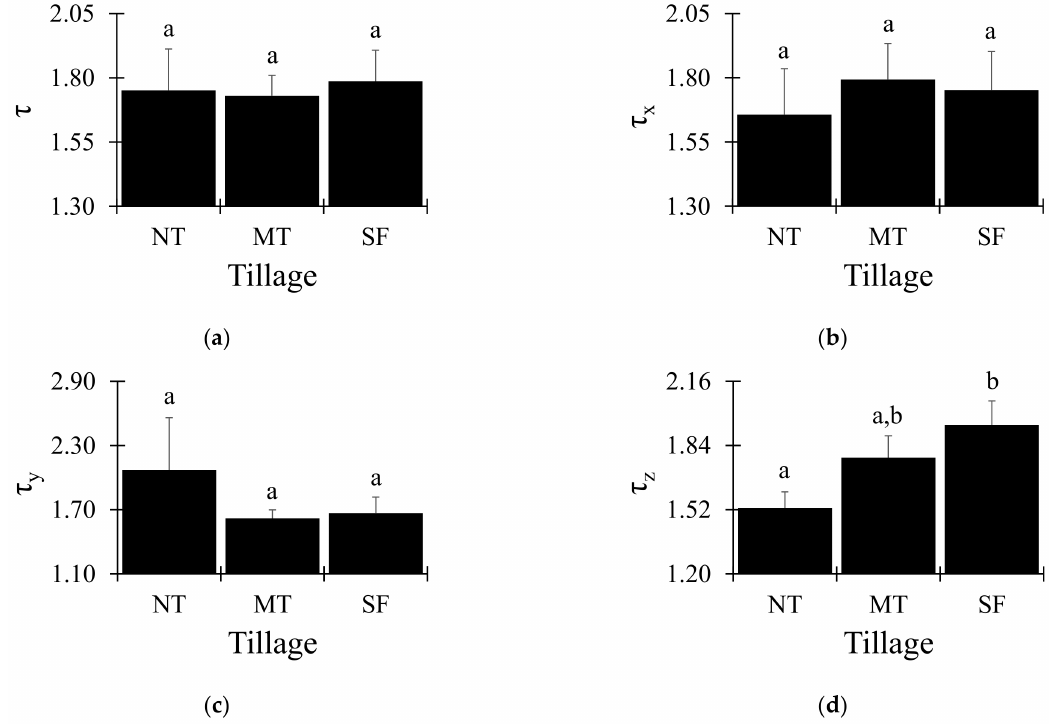
Figure 6. ( a ) Average pore tortuosity ( τ ), ( b ) pore tortuosity in the x direction ( τ x ) of the 3D image, ( c ) pore tortuosity in the y direction ( τ y ) of the 3D image, and ( d ) pore tortuosity in the z direction ( τ z ) of the 3D image for soil aggregates from no tillage (NT), minimum tillage (MT), and secondary forest (SF). The x, y, z directions of the 3D images do not reproduce the spatial directions of the original soil. Vertical bars represent the standard error ( n = 6). Different letters represent significant differences among management practices (Tukey’s HSD; p <